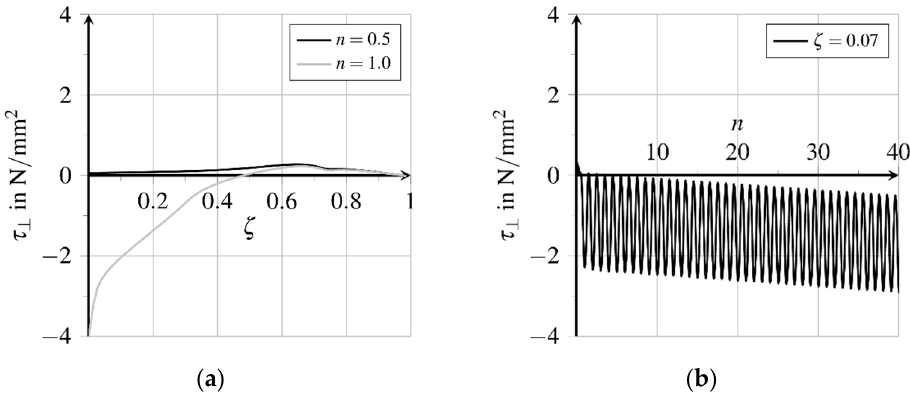
Figure 15. Evolution of bond zone normal stresses (adapted from [27]): ( a ) Stress distribution over bond length in first load cycle and ( b ) stress evolution near the fibre outlet at further load cycles.